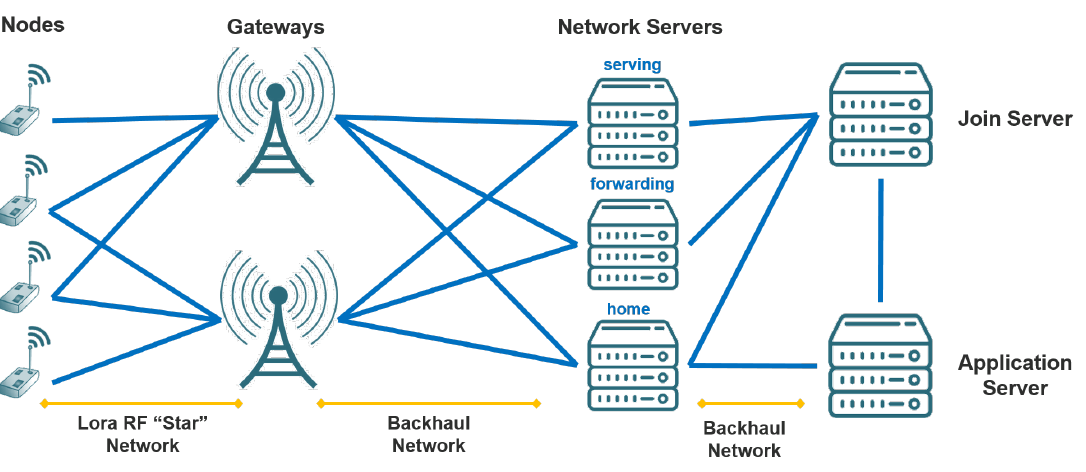
Figure 1. LoRaWAN v1.1 network architecture